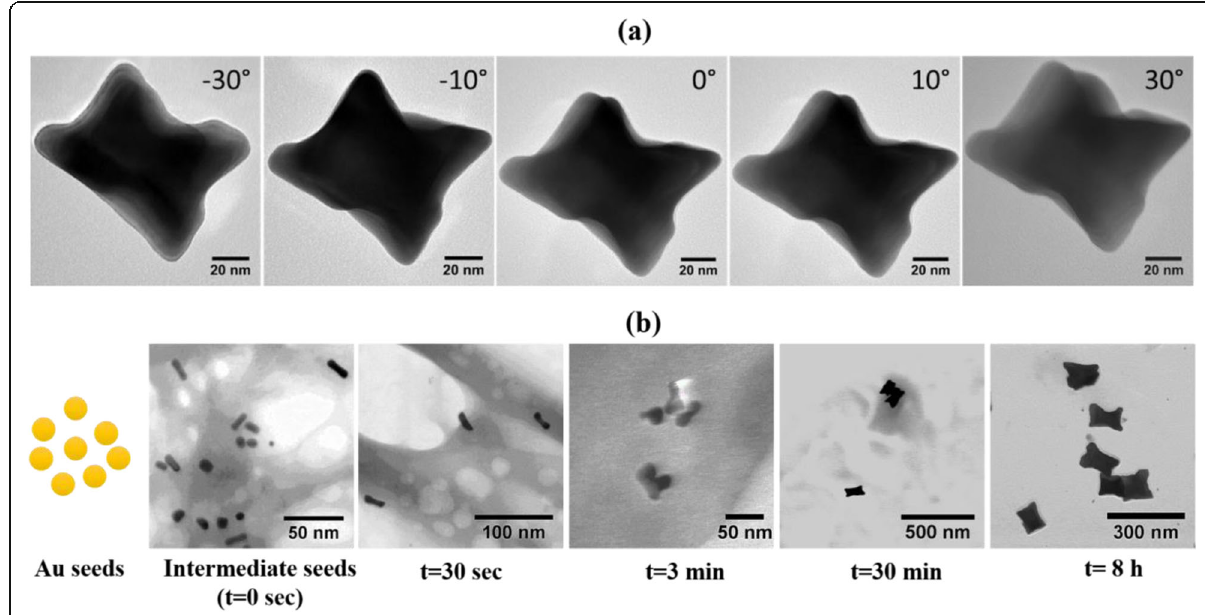
Fig. 3 Morphology and growth of Au NM (nano makura ). a TEM images of NM taken at different angles. b BF-STEM images show the growth steps in the formation of NM type Au NSs. The solution taken from the growth solution at different time points was added directly to TEM grid without purification